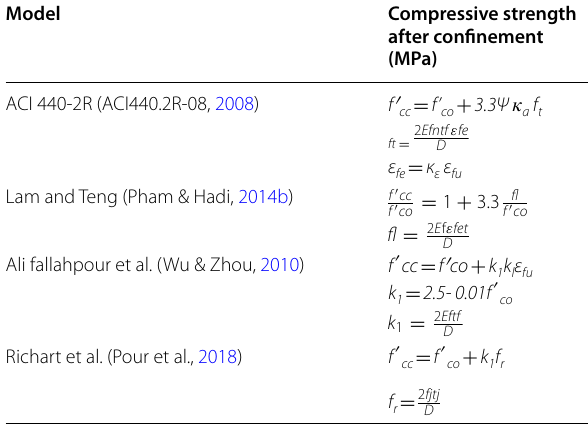
Table 12 Models for prediction of compressive strength after